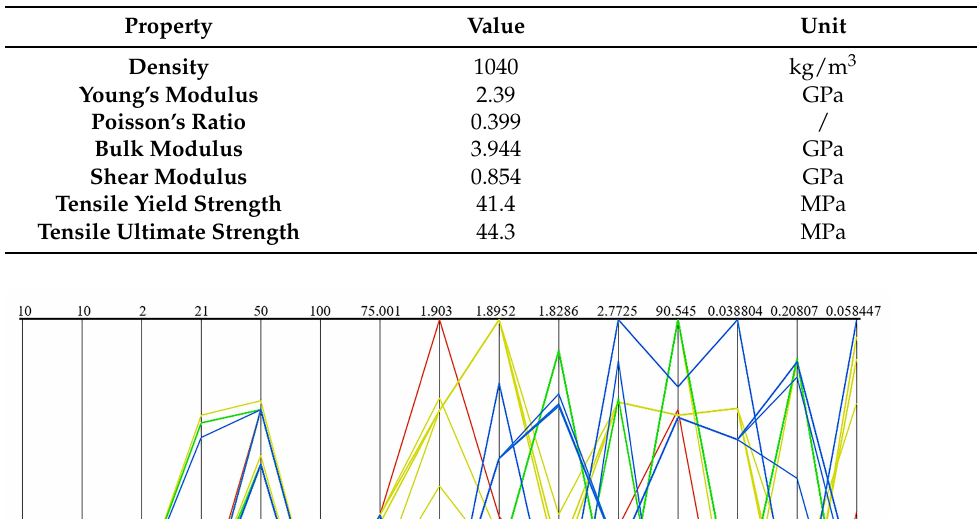
Table 3. Mechanical properties of ABS plastic materials.